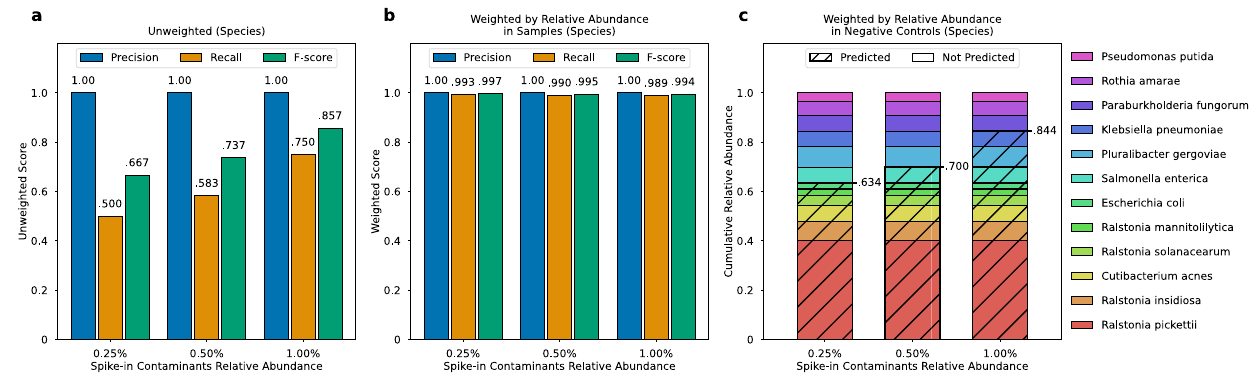
Fig. 5 | Squeegee prediction accuracy at species ranks on the simulated data- sets. a The leftmost panel shows the precision, recall, and F-score calculated at species rank for the different relative abundance of spike-in contaminants. The unweighted precision is calculated as the ratio between the number of predicted contaminant taxa found in the ground truth and the total number of predicted contaminant taxa. The unweighted recall is calculated as the ratio between the number of predicted contaminant taxa found in the ground truth and the total number of taxa in the ground truth. b The center panel shows the same